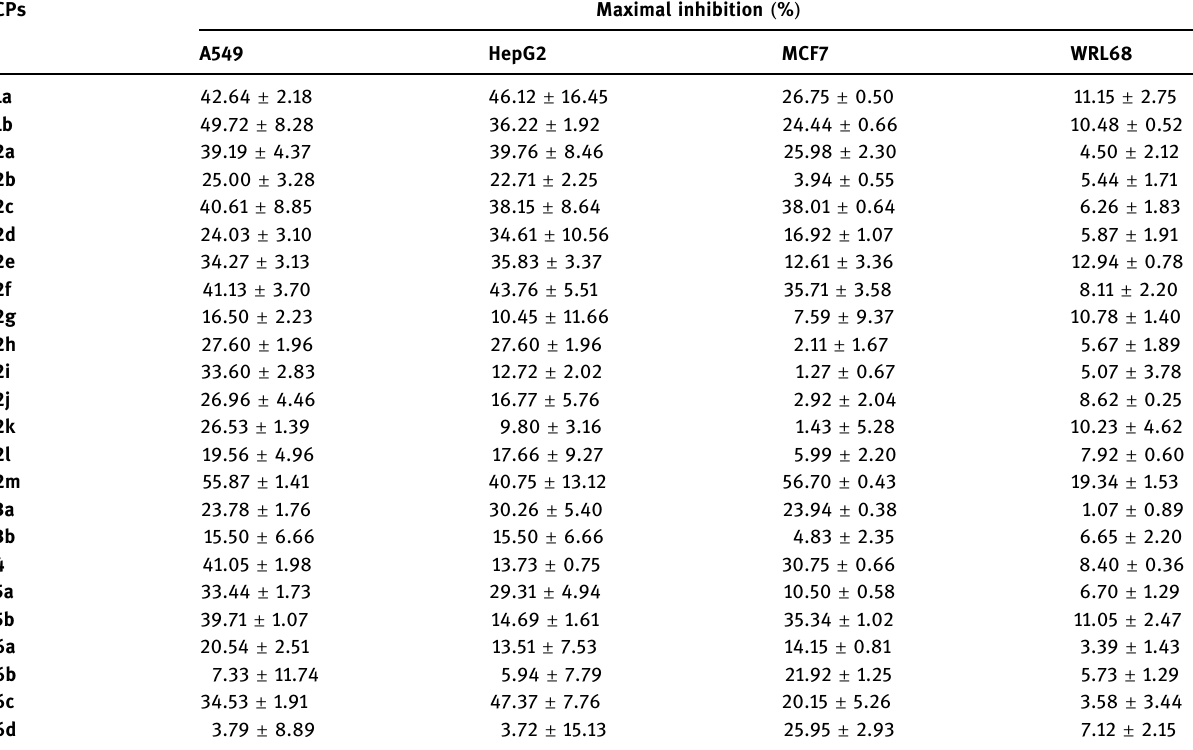
Table 2: Maximal percentage of cell viability at 200 µg/mL of samples against A549, HepG2, MCF - 7, and WRL68 cell lines